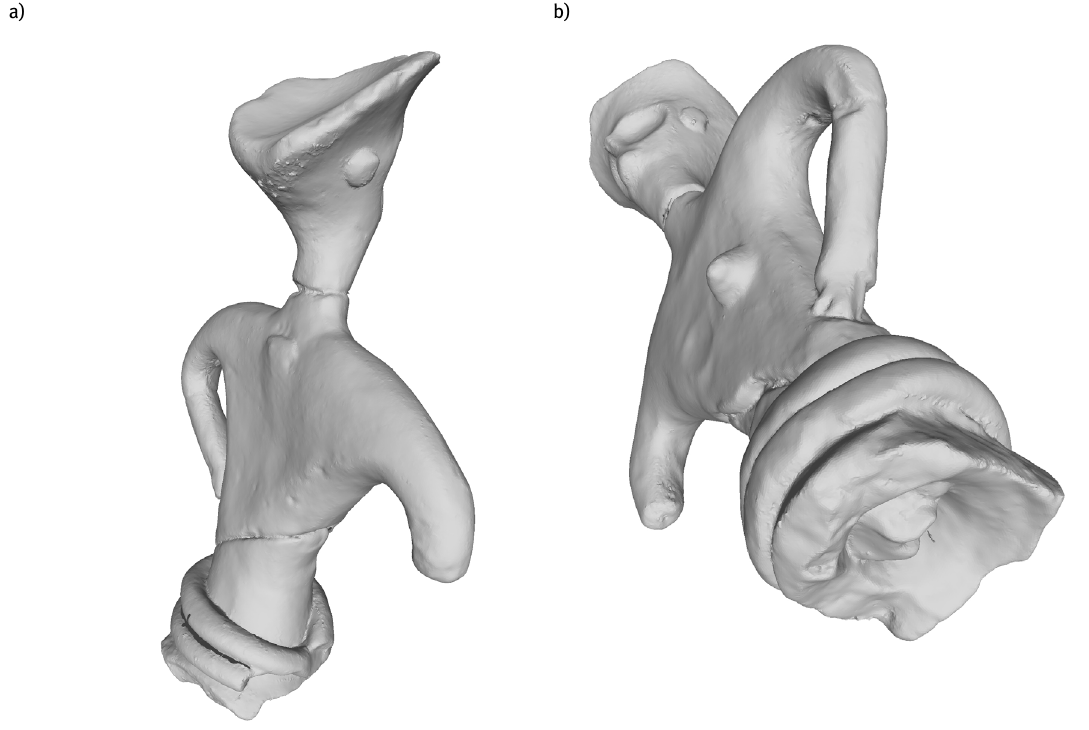
Figure 5. Stills from the digital model of HN